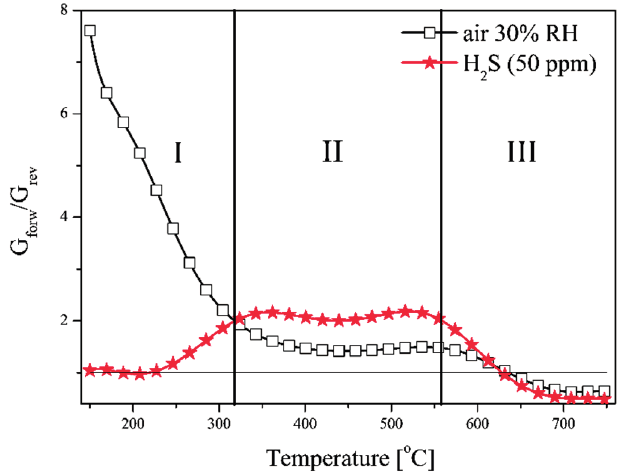
Figure 10. The temperature characteristics of the ratio of conductance as determined at various polarization directions in function of the composition of gaseous